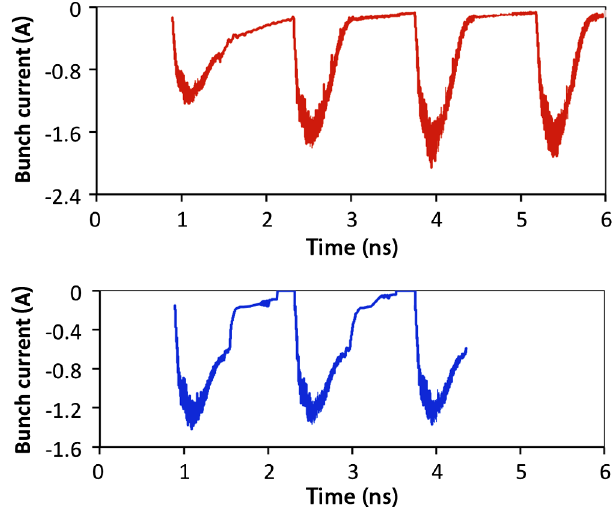
¼ 1 : 65 A and (center) FIG. 13. Comparison of electron bunches at the gun exit with lens emission from the central hole (top) and without emission from the central hole